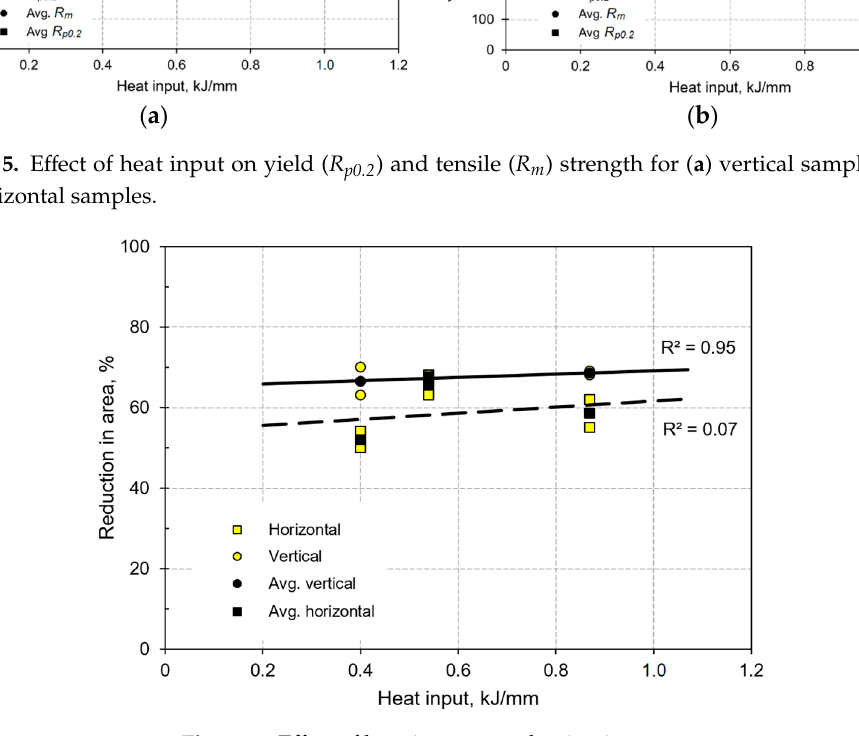
Figure 6. Effect of heat input on reduction in area.